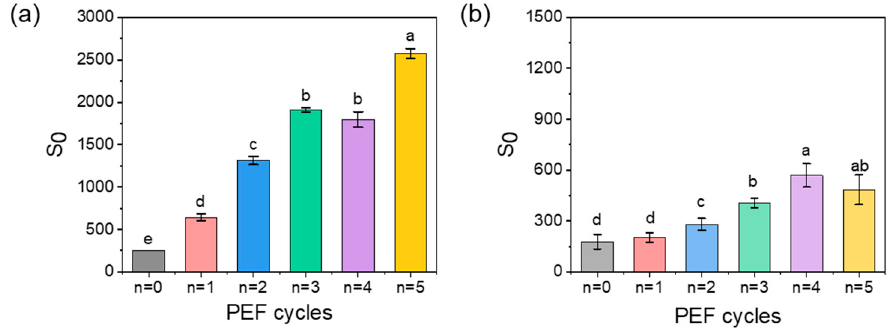
Figure 7. The S 0 of α -amylase ( a ) and α -amylase/ λ -carrageenan with a ratio of 10:1 ( b ) after PEF treatment, n represents the number of cycles. Letters a–e inserted in figures for degree of significance, p <